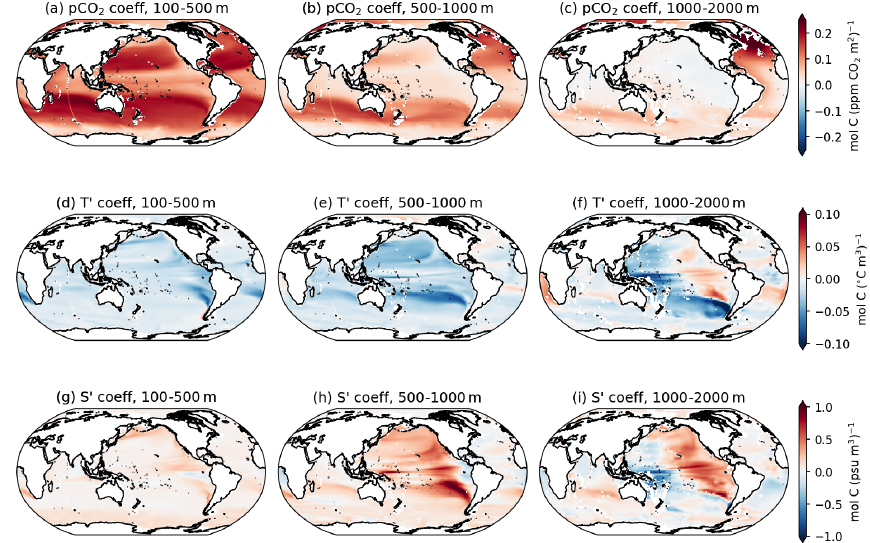
Figure 7. Optimal coefficients for interior DIC as a function of p CO 2 (molCm − 2 ppm − 1 , a–c ), temperature (molCm − 2 ◦ C − 1 , d–f ), and salinity (molCm − 2 psu − 1 , g–i ). Columns show coefficients for interior ocean layers: 100–500m (a, d, g) , 500–1000m (b, e, h) , and 1000– 2000m (c, f, i) .